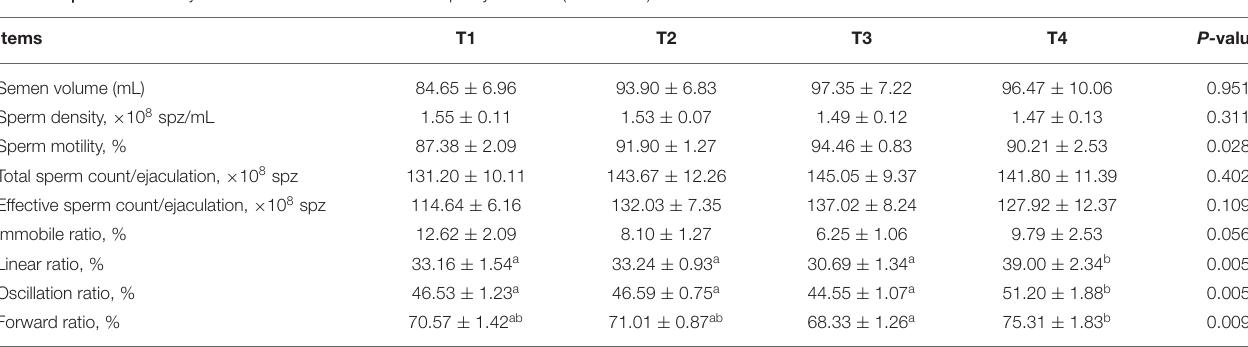
TABLE 4 | Effect of dietary fiber and metabolites on semen quality of boars (1–4